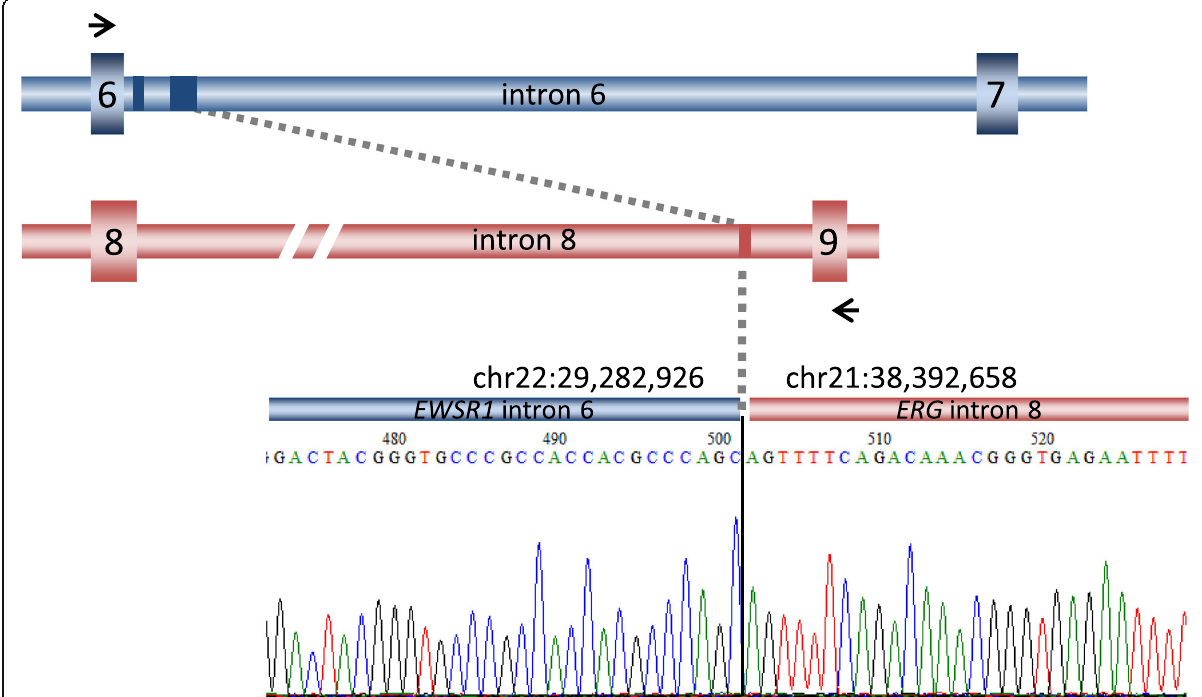
Fig. 6 Genomic fusion point of novel EWSR1-ERG translocation. Sequences of the genomic fusion point. The blue boxes indicate cryptic exons in the in-frame transcript. The black arrows indicate primer sites. In the upper part of the sequences, the chromosome positions of the fusion site are